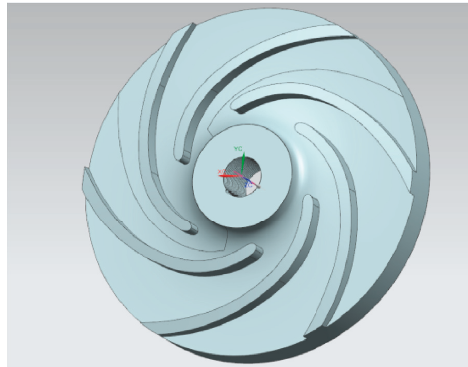
Figure 19: Three-dimensional diagram of lining pump.